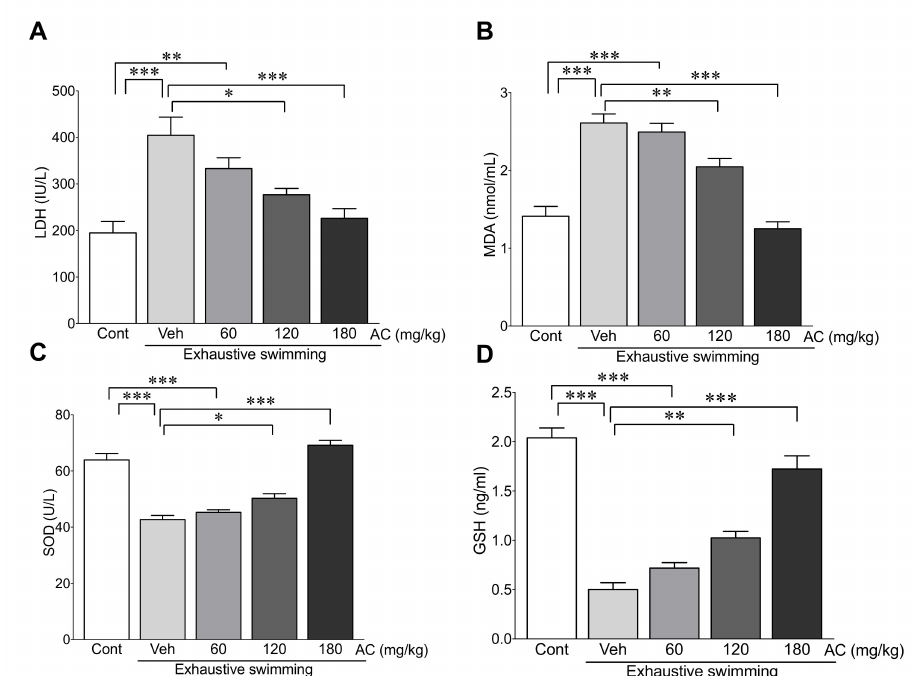
Figure 7. AC extract attenuated oxidative stress induced by exhaustive swimming. The serum levels of ( A ) LDH, ( B ) MDA, ( C ) SOD, and ( D ) GSH were measured in rats after AC pre-treatment for three weeks ( n = 10 per group). Data are mean ± standard error of mean (SEM). Significance was measured using one-way analysis of variance (ANOVA) followed by Bonferroni’s post hoc test. * p < 0.05, ** p < 0.01, and *** p < 0.001. Cont, control; Veh, vehicle-treated; 60, 120, and 180 AC, 60, 120, 180 mg / kg AC extract-treated groups, respectively. AC, Aralia continentalis kitagawa extract; LDH, lactate dehydrogenase; MDA, malondialdehyde; SOD, superoxide dismutase; GSH,